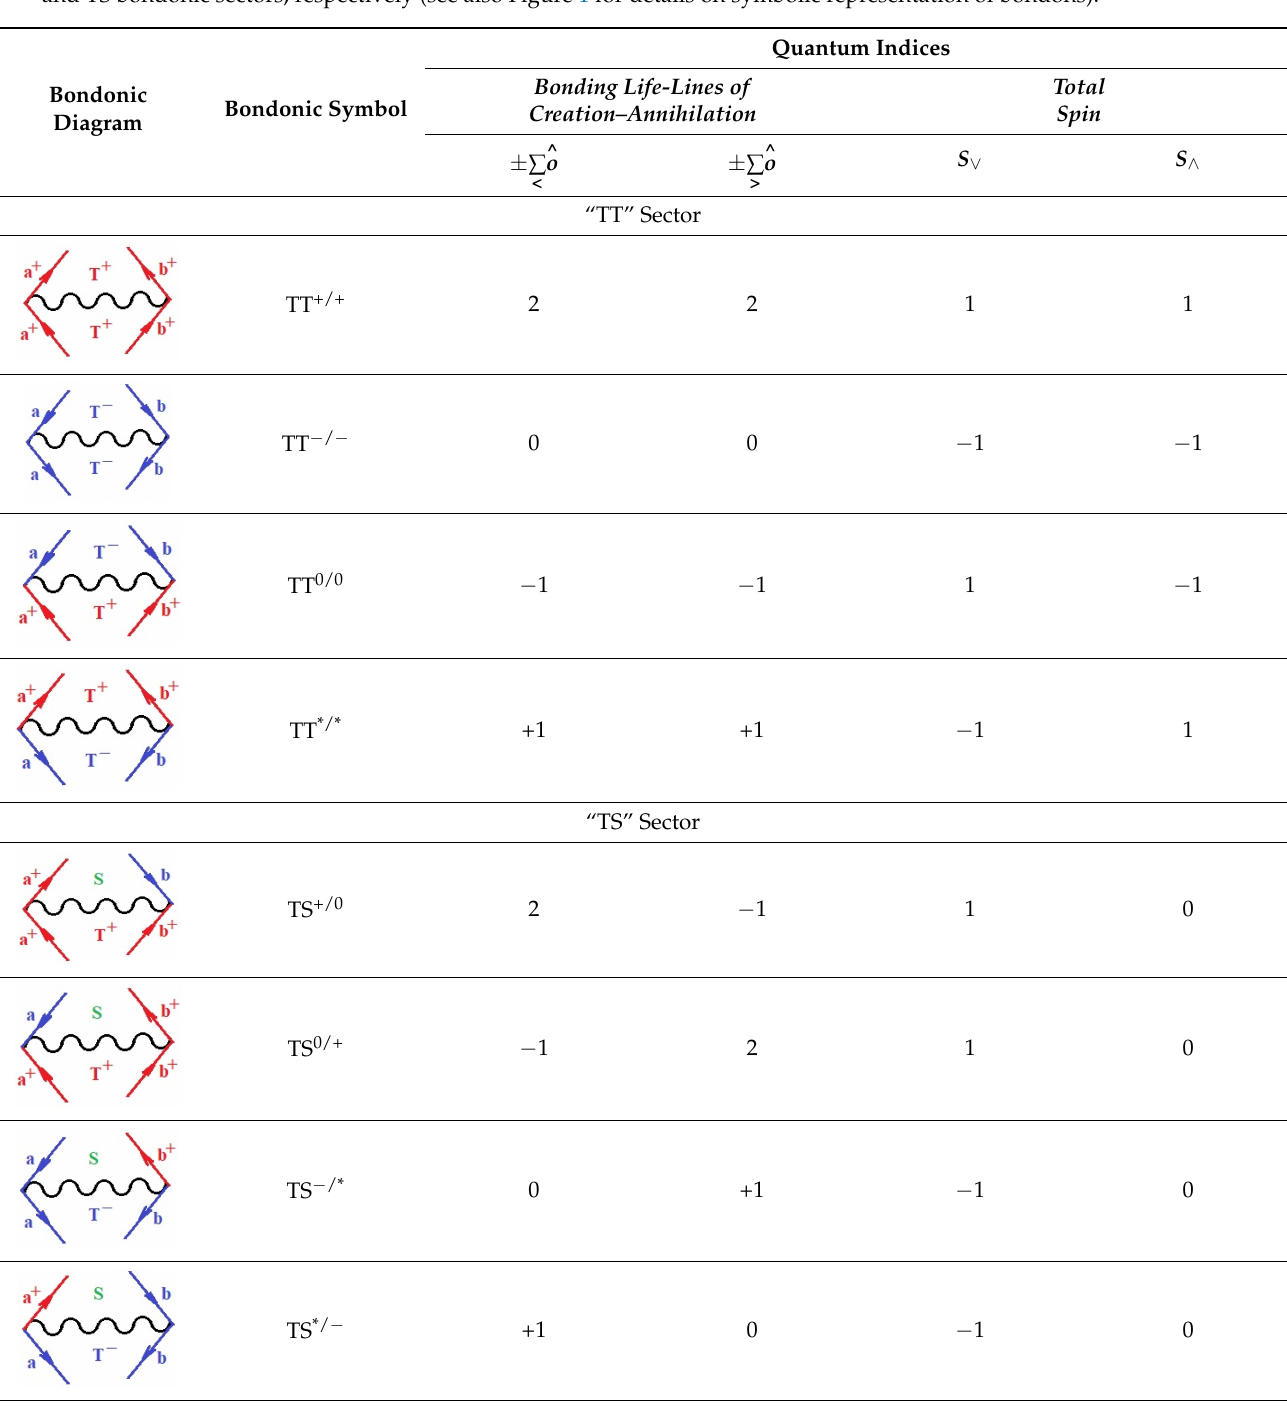
Table 1. Bondonic Feynman’s-type diagrams for the triplet (T), singlet (S) and mixed sectors of creation–annihilation life-lines of creation–annihilation of valence electrons in generic chemical bonding; the corresponding left (<) and right (>) time-ordering contraction for the operatorial eigenvalues are respectively considered relative with the “present” in or out electrons in bonding (see text for further details); the resulting total spin for past ( ∨ ) and future ( ∧ ) “histories” of in and out valence electrons in bonding are also considered and correlated with the triplet and singlet total spin in each of TT, SS, ST and TS bondonic sectors, respectively (see also Figure 1 for details on symbolic representation of